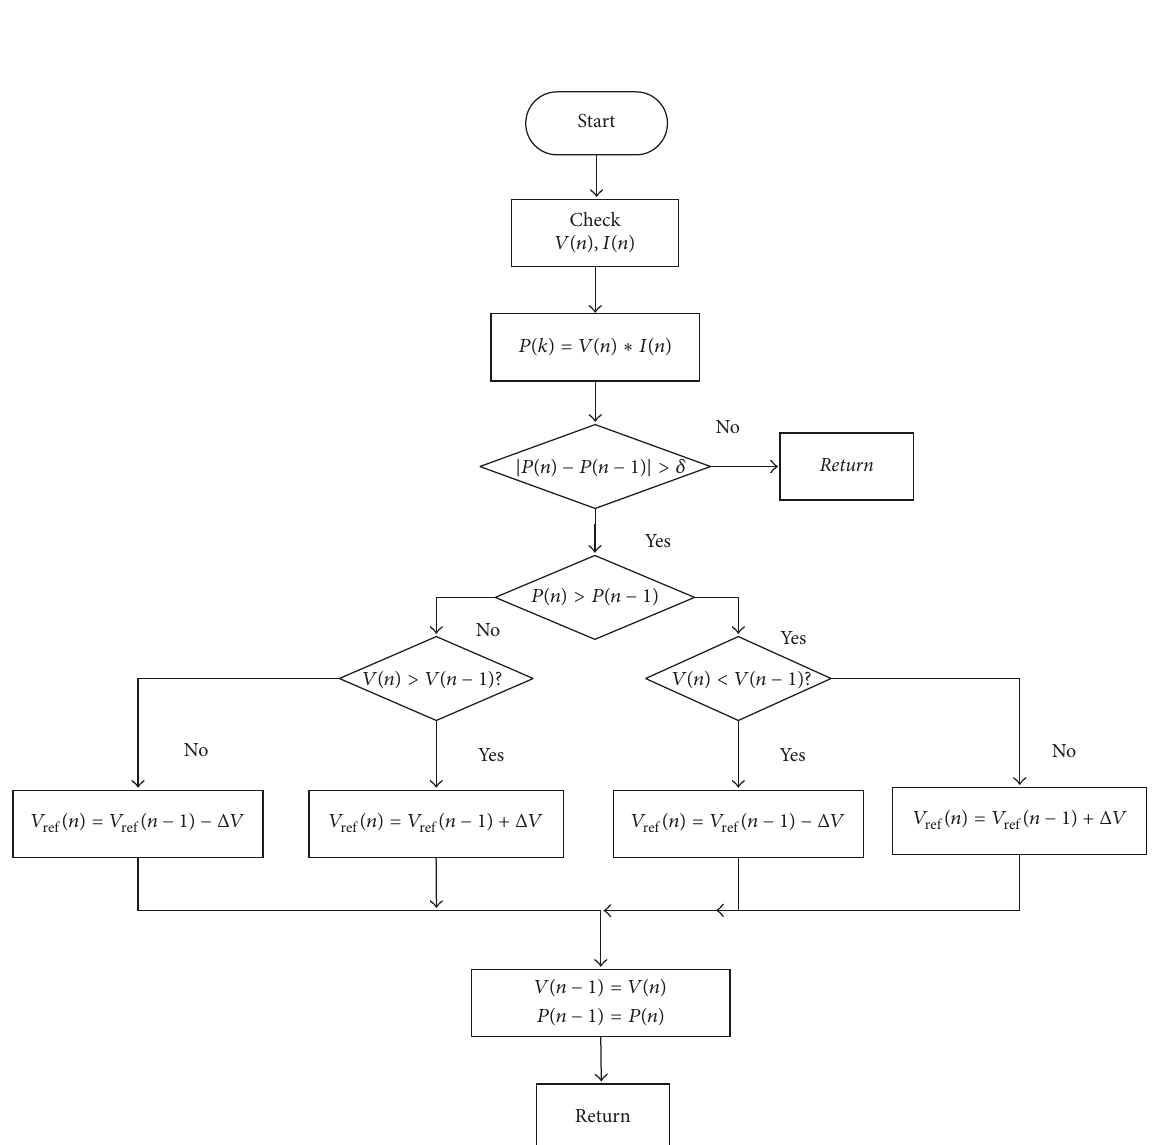
Figure 3: Control flow diagram of P&O